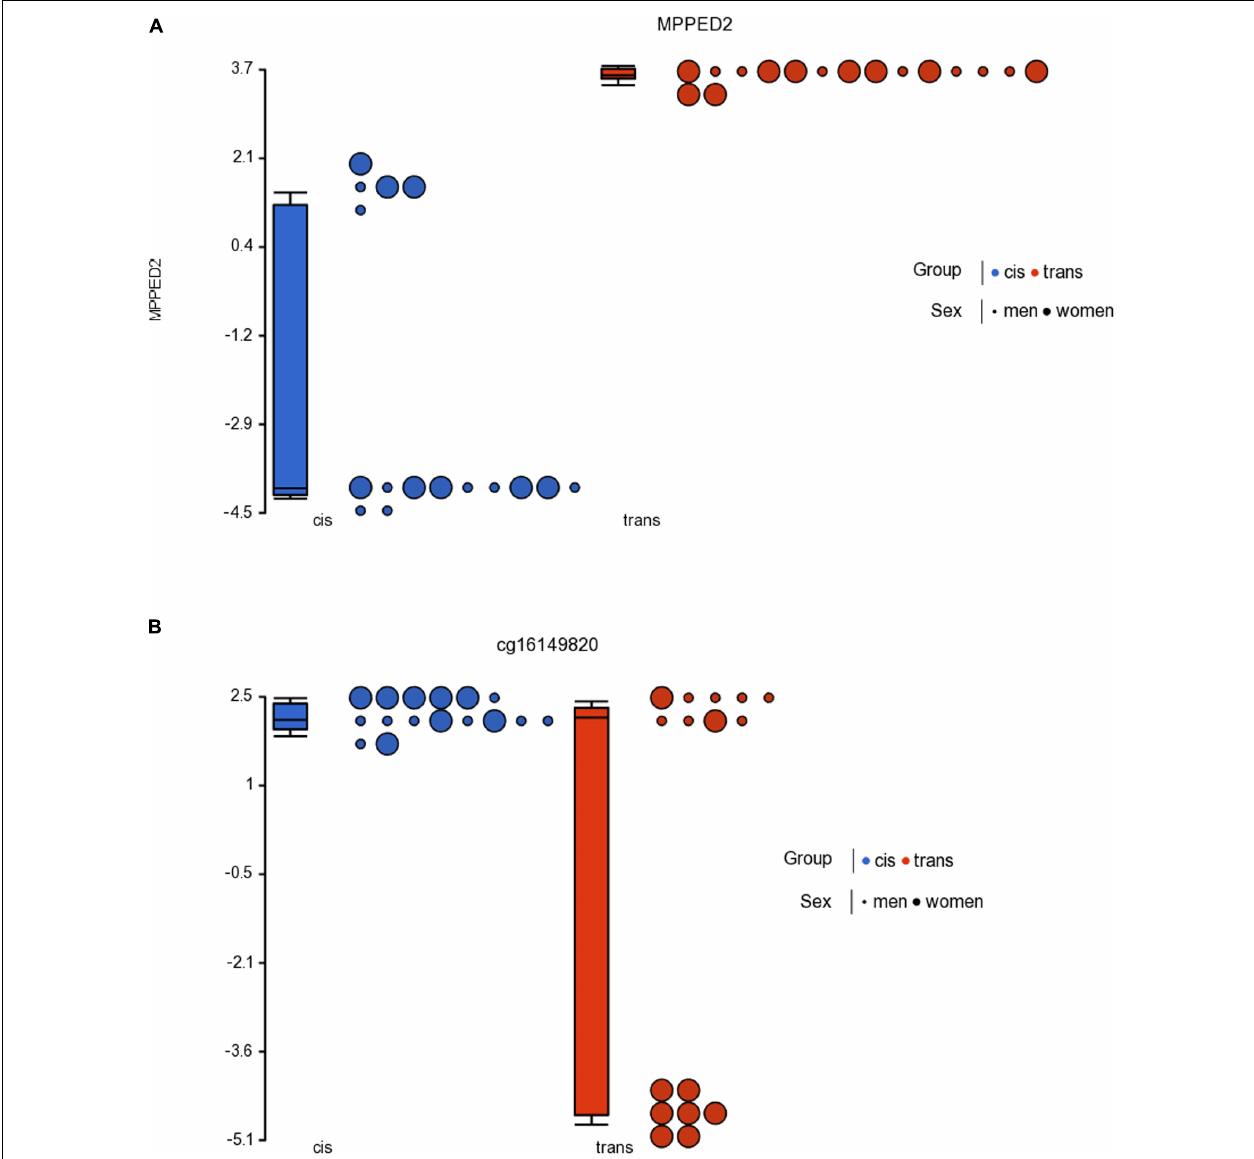
FIGURE 4 | Dot plot showing M -value data for cg23944405 (A) in the MPPED2 gene and cg16149820 (B) for cisgender vs. transgender populations by sex assigned at birth. Each sample is represented by a dot. The samples are colored according to the levels of the variable “group” (blue for cisgender population and red for transgender population), and sized according to the levels of the variable “sex assigned at birth” (big for women and small for men). The middle line is the median, the box represents the upper and the lower quartile, while the whiskers correspond to the 90th and 10th percentiles of the